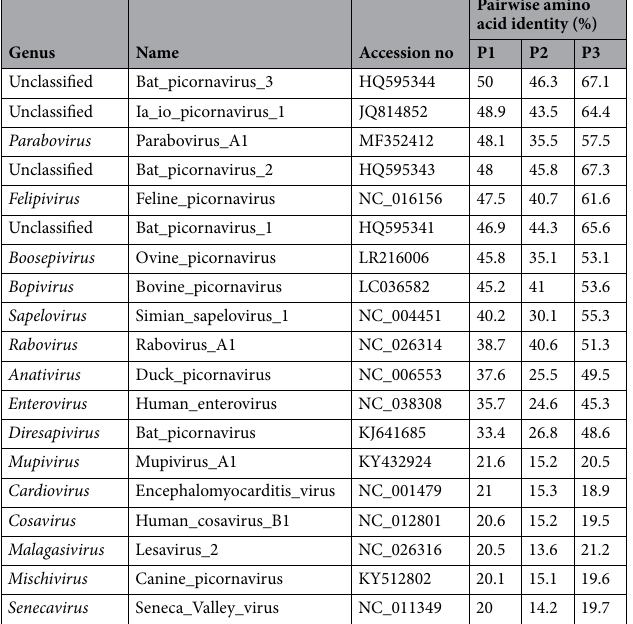
Table 2. Comparison of genomic features of PicoV-HMU-1 and other species of picornaviruses.